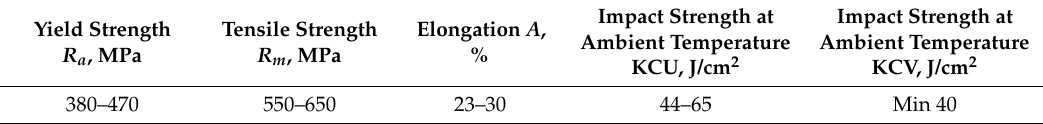
Table 2. Typical mechanical properties of 17G2SF steel according to GOST 19281-73 [3].